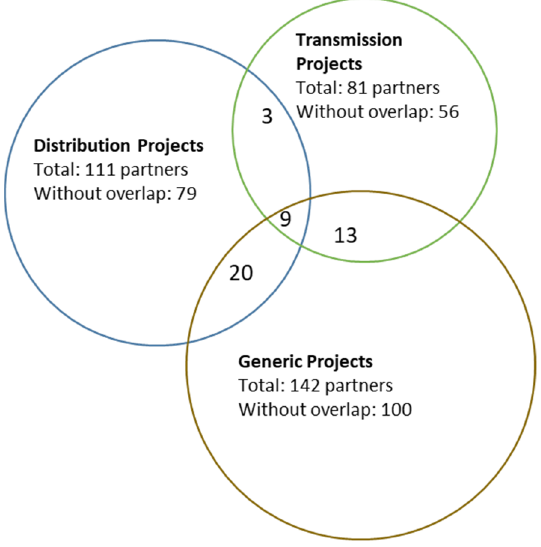
Figure 5. Overlaps between the participants in the three samples of FP6 projects.